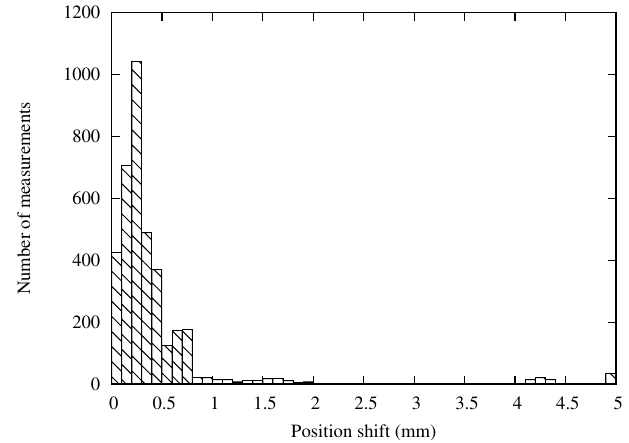
FIG. 8. Correction in the calculated position due to the capaci- tive calibration